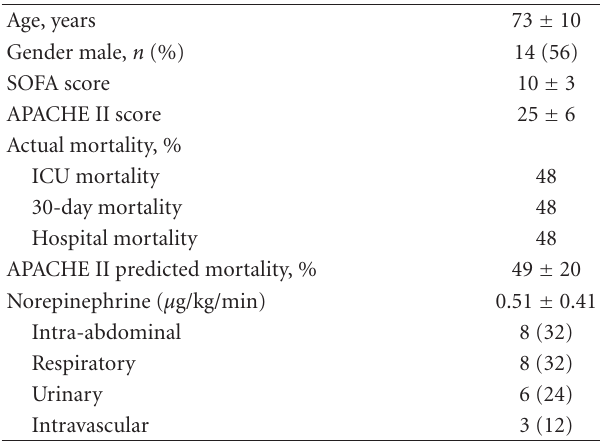
Table 1: Clinical and epidemiologic characteristics of the